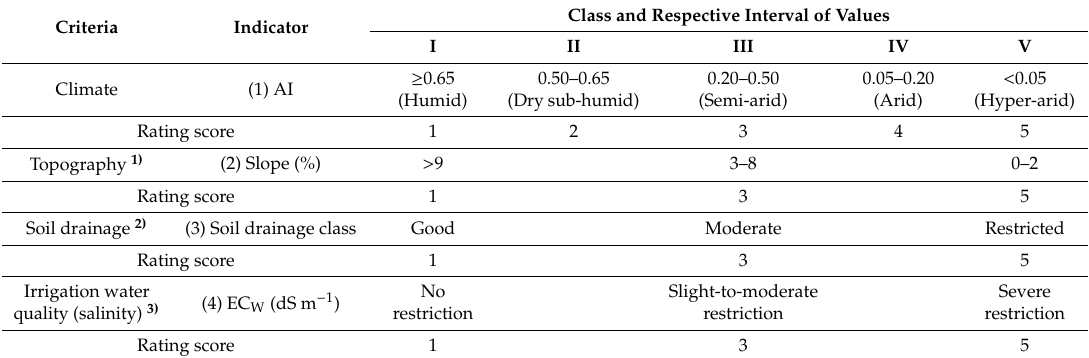
Table 5. Criteria, indicators, class limits, and their rating score to evaluate the risk of soil salinization in irrigation areas in the Salinization Risk index (RSA).